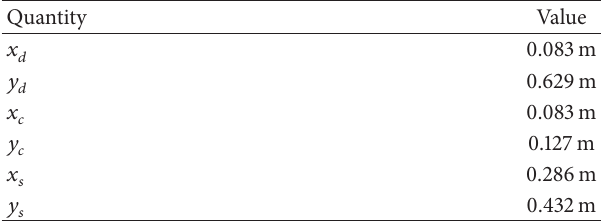
Table 4: Locations forthe disturbance, control, and sensorlocations of the simulations and